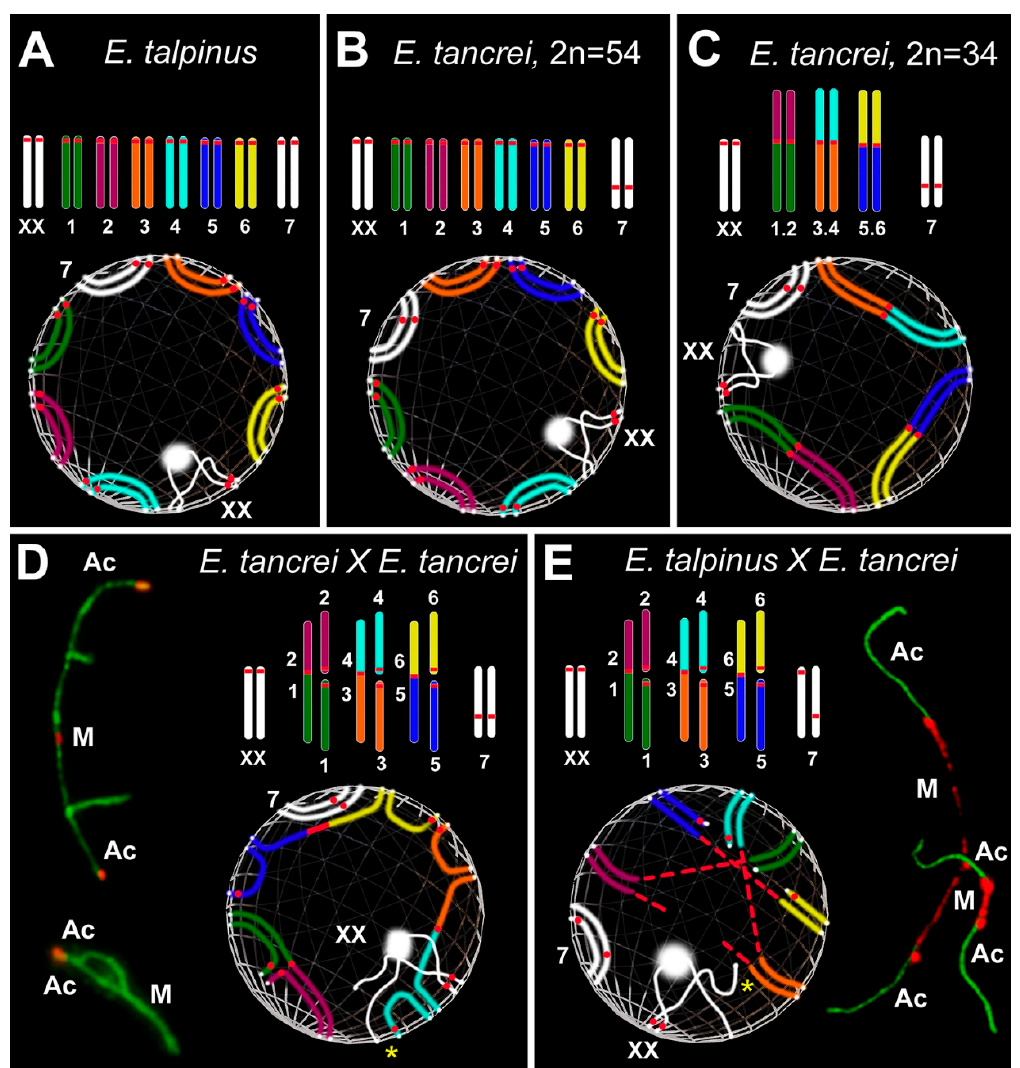
Figure 6. Simulation of chromosome synapsis and interactions of SC trivalents in pachytene nuclei of Ellobius species and hybrids. A partial set of chromosomes and lower—inside the spheres—features of the configuration of the axial elements of these chromosomes during synapsis at the pachytene stage are presented in each part of the Figure. White dots at chromosome ends mark the attachment points of the chromosomes to the nuclear envelope. M indicates metacentric and Ac indicates acrocentric (D,E). ( A , B ) Chromosomes: Seven pairs of autosomes and a pair of isomorphic sex (XX) chromosomes in A and B. The chromosome sets differ from each other only in the chromosome 7 pair: acrocentric in Ellobius talpinus (2 n = 54), neocentromeric submetacentric in Ellobius tancrei (2 n = 54). Spheres: The positions of SCs over the nuclear envelope in the pachytene nuclei in A and B are different, because it is assumed that chromosome territories can be distinguished between two species [94,134]. ( C ) Chromosomes: Conditional karyotype of E. tancrei (2 n = 34) consists of three pairs of homologous Robertsonian (Rb) metacentrics (1.2, 3.4 and 5.6), a submetacentric chromosome #7 pair and sex (XX) chromosomes. Sphere: The chromosomal arms of metacentrics do not always occupy the ancestral position (compare spheres A, B, and C), because Rb metacentric formation causes a shift in the chromosome territories in the meiotic nucleus (see [94,120]). ( D ) Chromosomes: Karyotype of the intraspecific hybrid E. tancrei obtained from crossing two forms (2 n = 54 and 2 n = 34). The scheme of partial karyotype shows three Rb metacentrics (1.2, 3.4, 5.6) and six acrocentrics (1–6). Sphere: Three Rb metacentrics and acrocentrics form three SC trivalents. They are attached to the nuclear envelope and part of them remains open for a long time at the mid pachytene. The synapsis of chromosomes in all SC trivalents is gradually completed to the diplotene, which will ensure their correct segregation in the future. Open and closed SC trivalents are presented on the left. ( E ) Chromosomes: Karyotype of